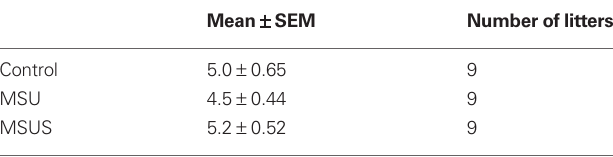
Table 2 | Number of pups/litter in F 1 mice.